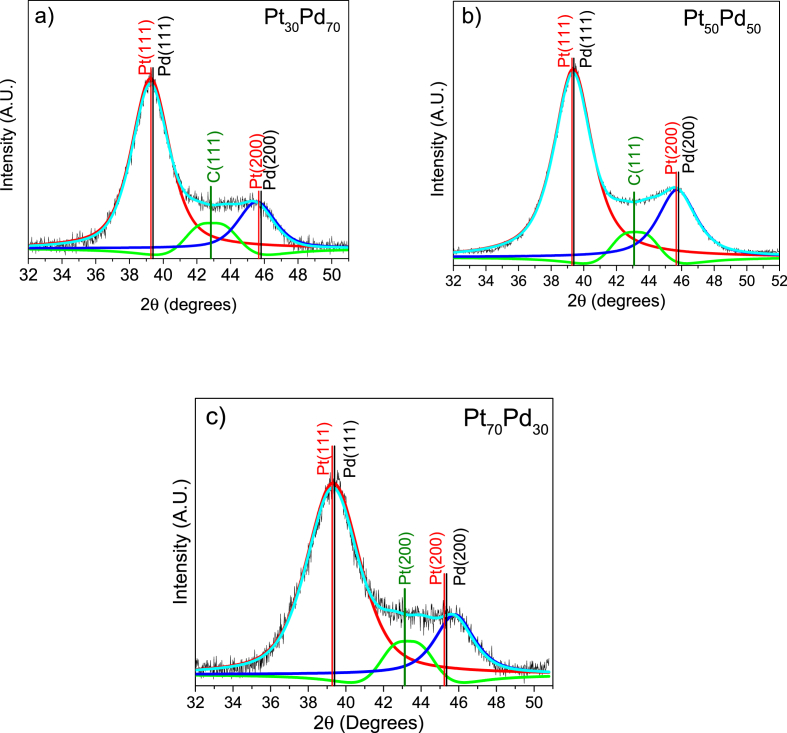
Deconvolution of X-ray diffraction patterns using the PseudoVoigt equation of a) Pt30Pd70, b) Pt50Pd50 and c) Pt70Pd30.